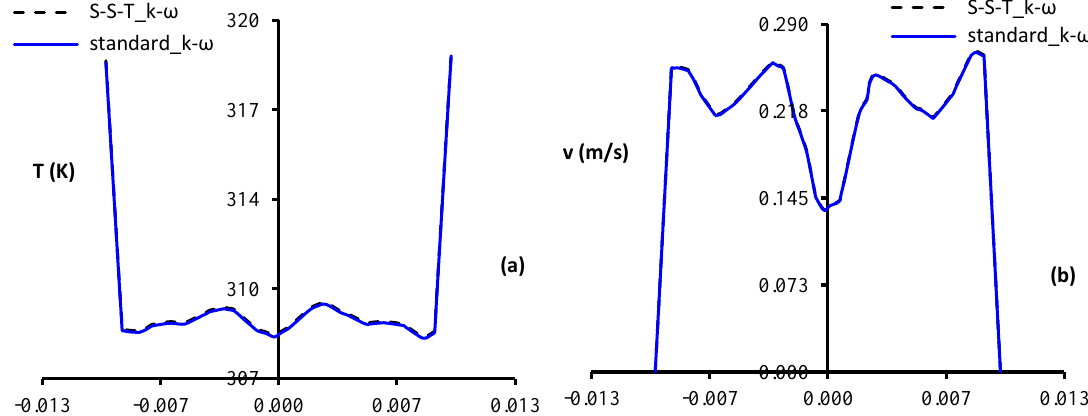
Figure 3. SST 𝛋 − 𝛚 model compared with standard 𝛋 − 𝛚 model for 𝑹𝒆 = 𝟒, 𝟔𝟓𝟎 : (a) temperature, (b)